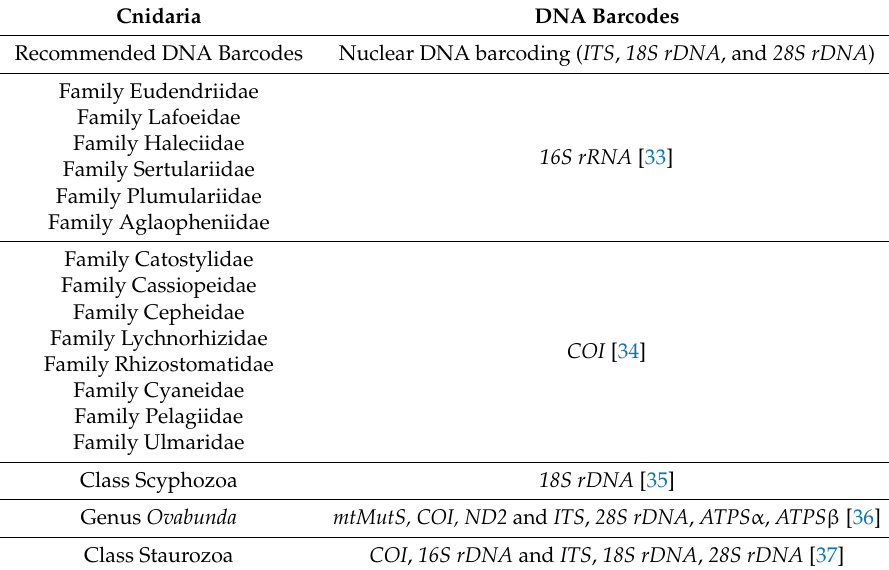
Table 4. Commonly used DNA barcodes in Cnidaria.